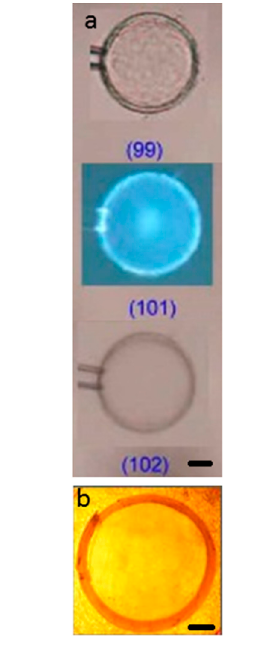
Figure 4 . ( a ) Visualization of the protein rich shell in microgel E during deswelling in 500 mg/L lysozyme solutions (NaCl/tris buffer; pH 8.0, I = 10 mM). Shown are microscopy images taken with without condenser (top), with fluorescent light (middle), and with condenser (bottom) after 99, 102, and 101 min, respectively, after onset of experiment as indicated; scale bar = 25 µm. Numbers indicate the time in minutes after exposure to the protein solution; ( b ) photo of a thin slice through the PSS macrogel with lysozyme-rich shell ( β = 0.55); scale bar = 2.5 mm.